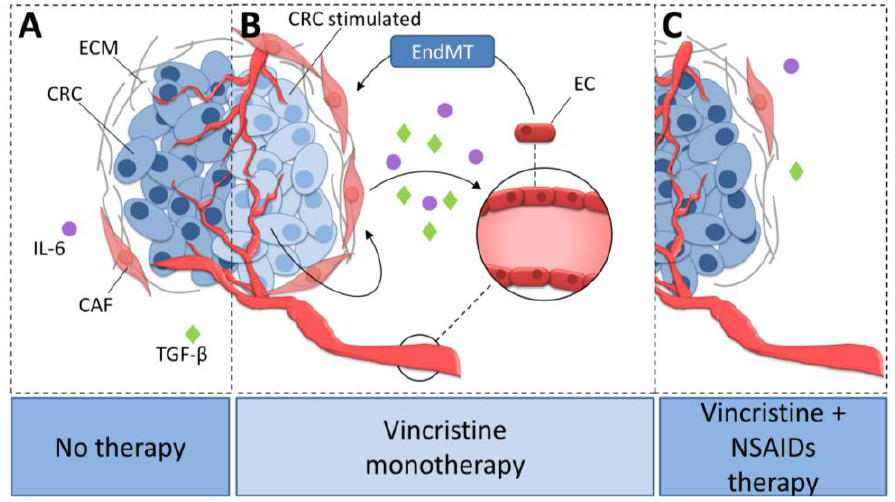
Figure 8. The role of NSAIDs in the inhibition of vincristine-dependent CAFs formation in colon cancer cells. ( A ) CAFs stimulate colon cancer development. ( B ) Vincristine therapy induce EndMT in microvessel ECs through the increasing release of TGF- β s and IL-6 from CAFs. ( C ) The NSAIDs inhibit the vincristine-dependent secretion of TGF- β s and IL-6 from CAFs. Colon cancer cells stimulated with vincristine promote CAFs secretion ability. Activated CAFs increasingly release IL-6 and TGF- β s and therefore stimulate CAFs formation from EC cells through EndMT process. NSAIDs prevent CAFs formation through inhibition of IL-6 and TGF- β s secretion. CRC, colon cancer cell; CRC stimulated, colon cancer cell stimulated with vincristine; CAF, cancer-associated fibroblast; EC, endothelial cell; ECM, extracellular matrix; TGF- β , transforming growth factor- β ; IL-6, interleukin-6; EndMT, endothelial-to-mesenchymal transition.